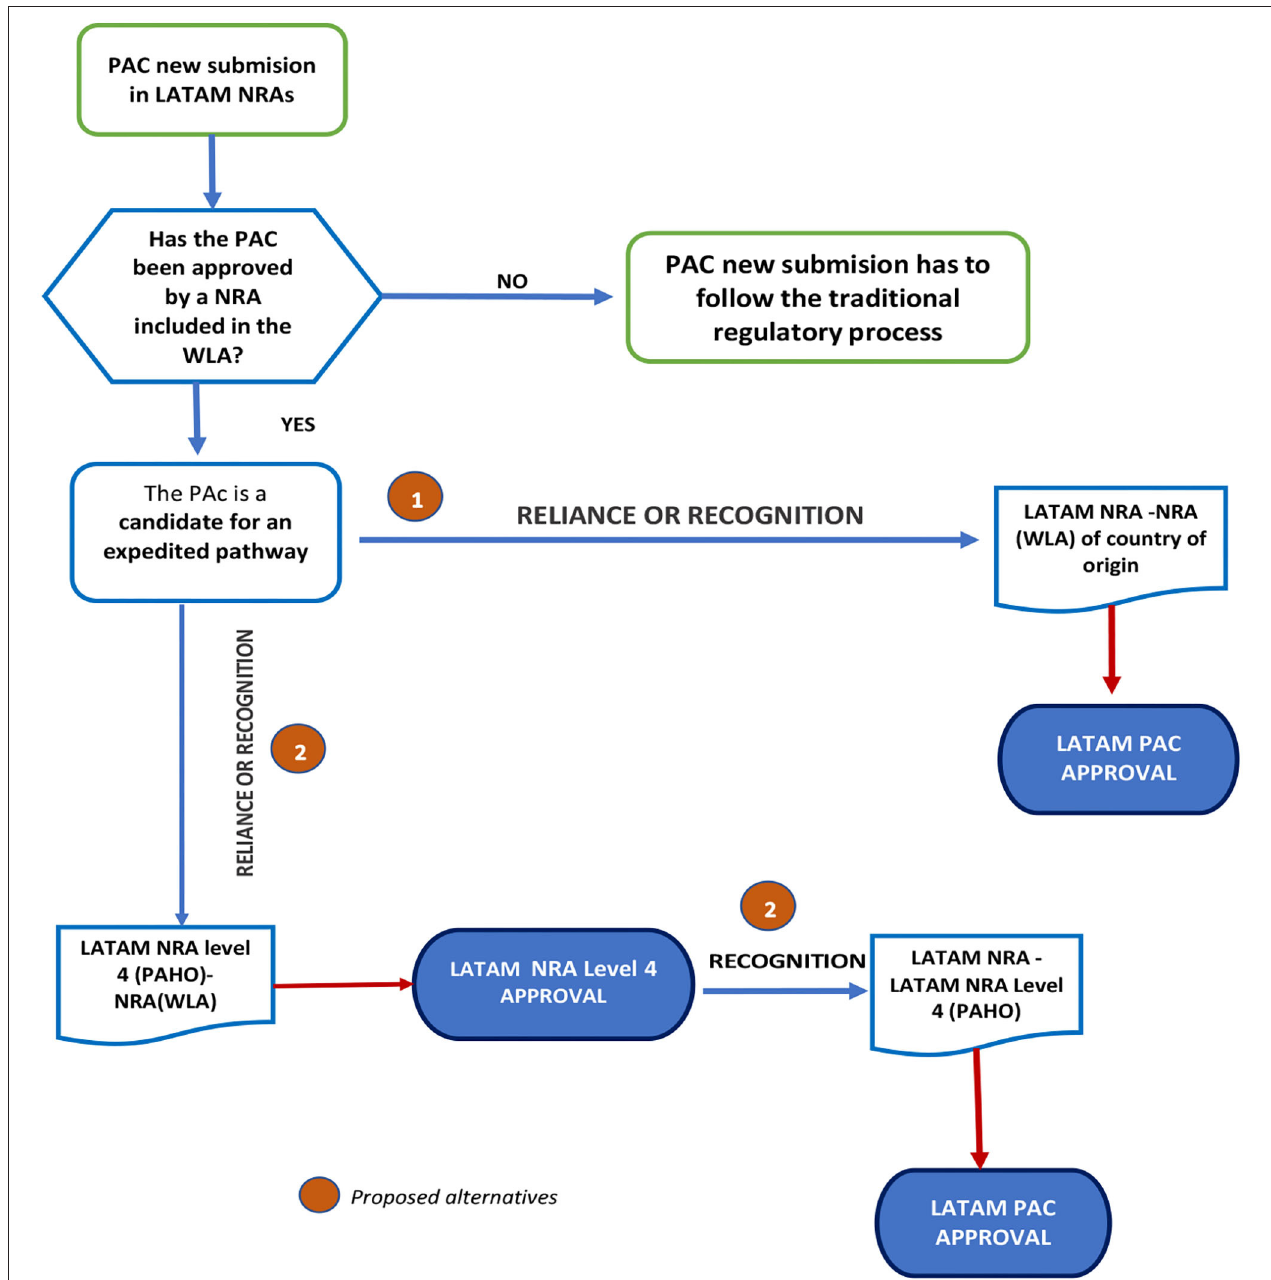
FIGURE 8 | Proposed flowchart for applying reliance or recognition for PACs submitted for prior